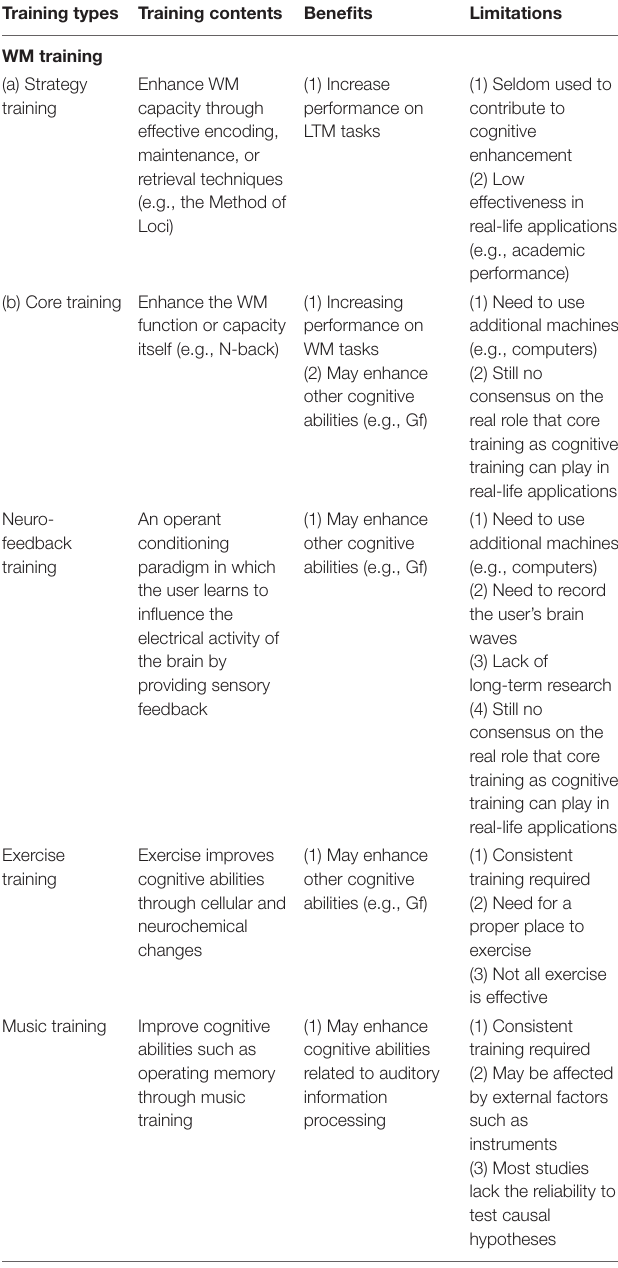
TABLE 1 | Benefits and limitations of existing cognitive